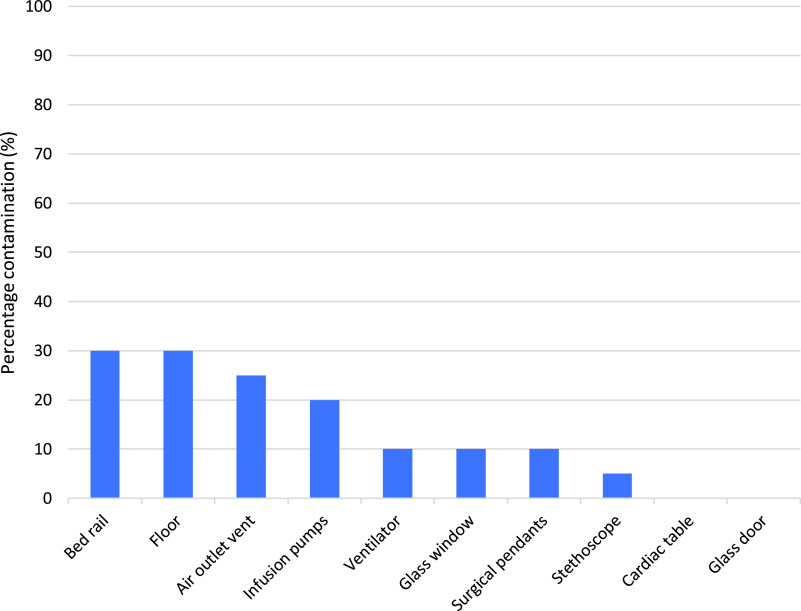
Percentage contamination by sites sampled in patient rooms.